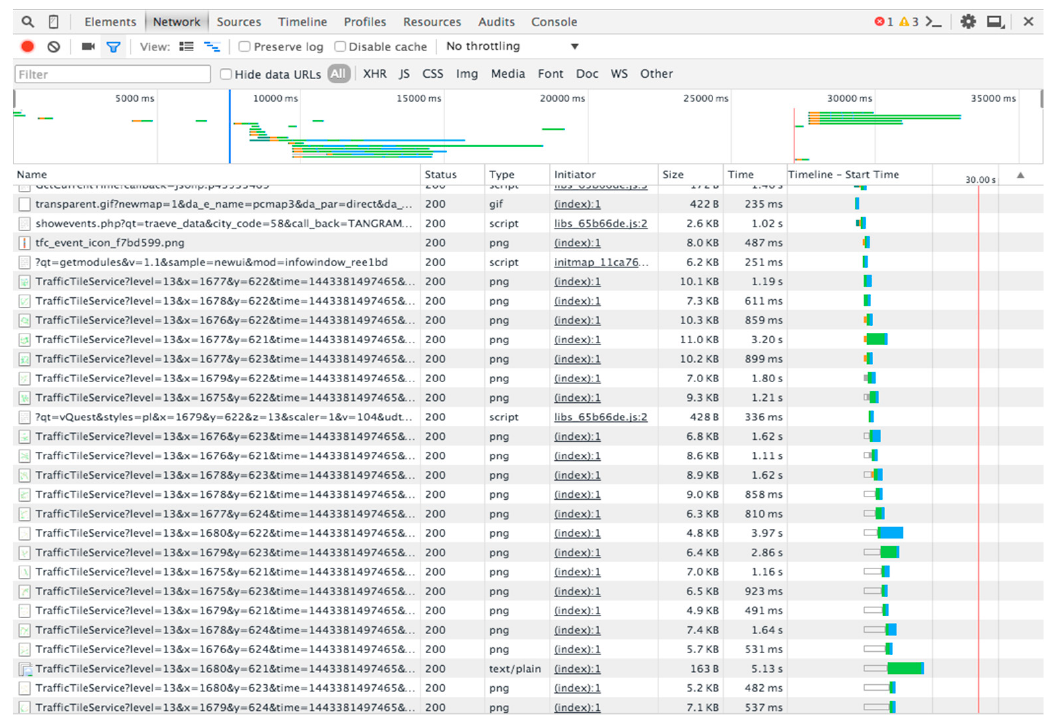
Figure 7. HTTP request analysis by Chrome developer tool.